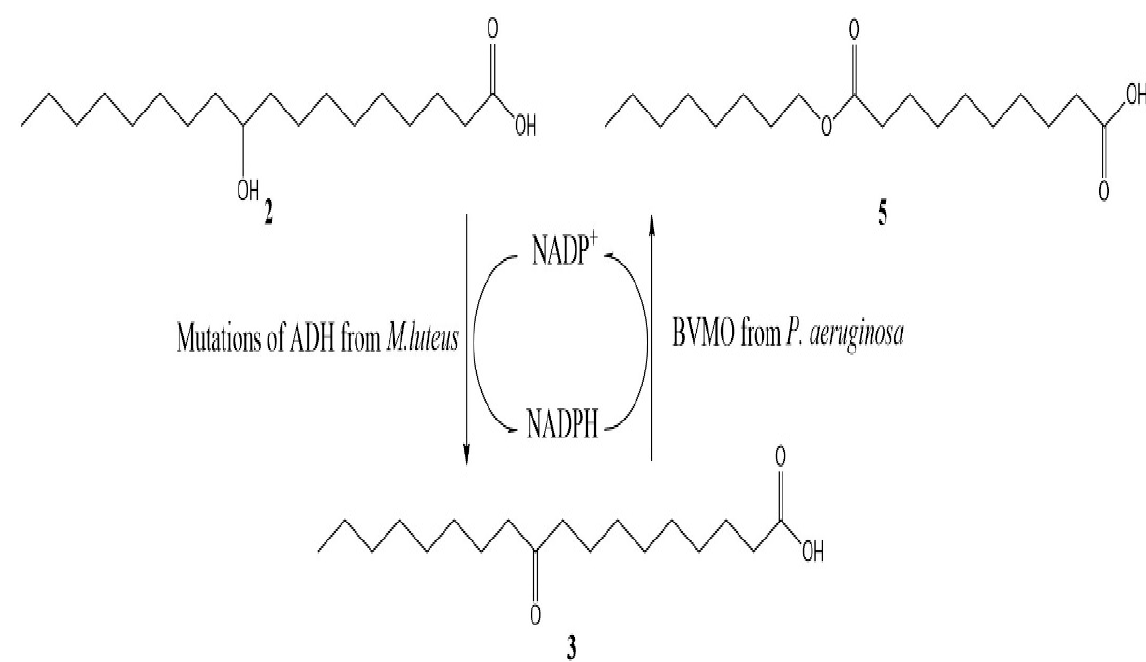
Scheme 2. Construction of a NADPH regeneration system by altering the co-factor specificity of a native NAD + -dependent ADH to NADP +